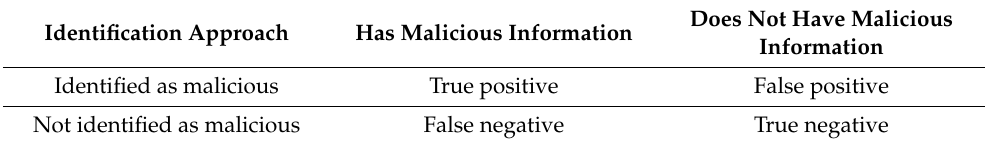
Table 3. Maliciousness confusion matrix.